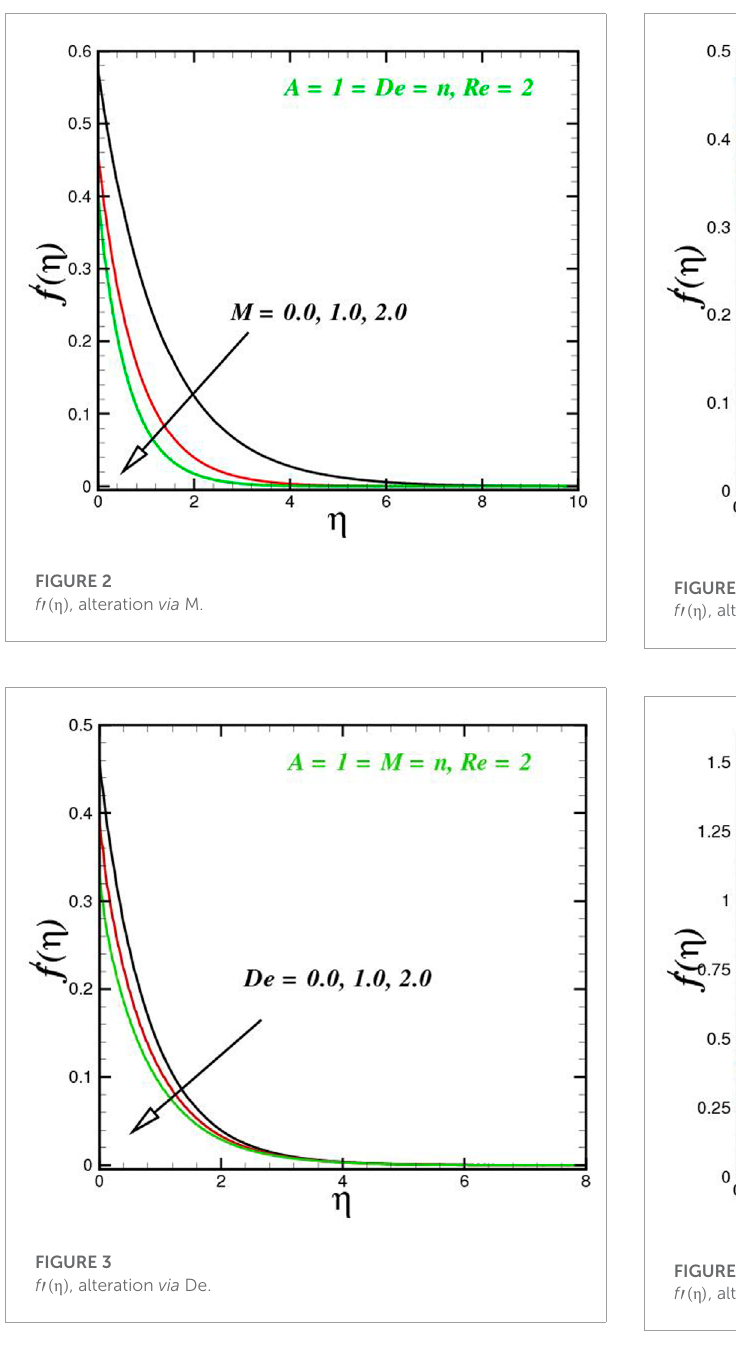
Here, f ′( η ) , θ ( η ) ,and ϕ ( η ) represents the dimensionless stream function,dimensionlesstemperatureandconcentration.Makinguse of non-dimensional transformation, the leading Eqs. (4.12)–(4.14) reduced to